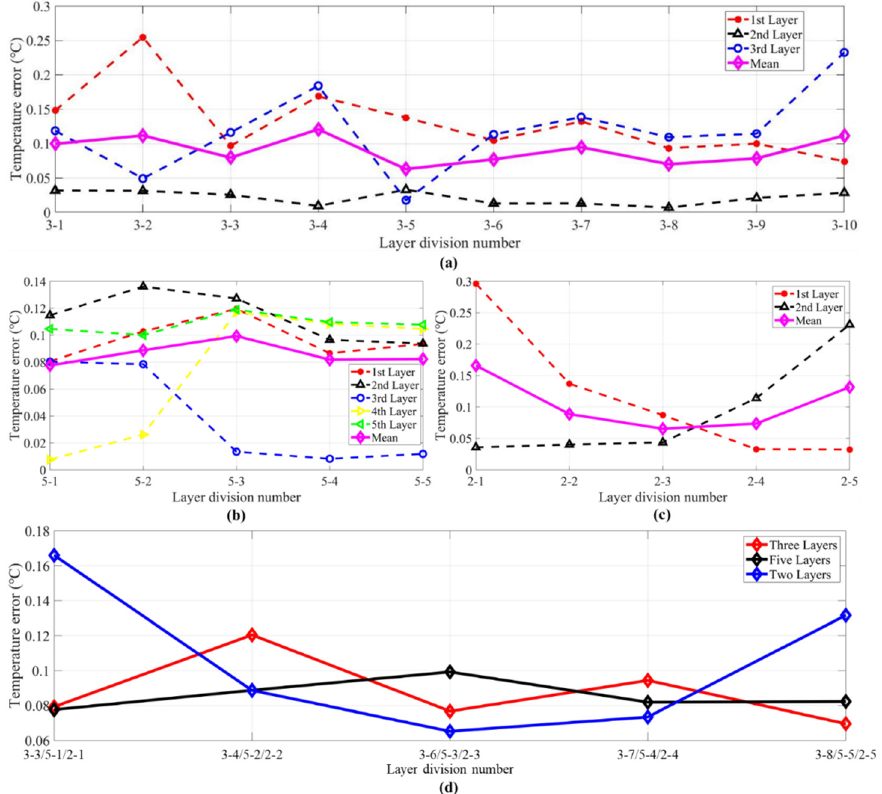
Figure 15. Inversion errors of the first group of S2 – S3 . ( a ) Temperature error of three layers. ( b ) Temperature error of five layers. ( c ) Temperature error of two layers. ( d ) Mean temperature error of three, five, and two layers. The red, black, blue, green, purple, and magenta curves in ( a – c ) indicate the mean errors of the first, second, third, fourth, fifth layer, and the mean errors of three layers, respectively. The red, black, and blue curves in ( d ) indicate three layers, five layers, and two layers.